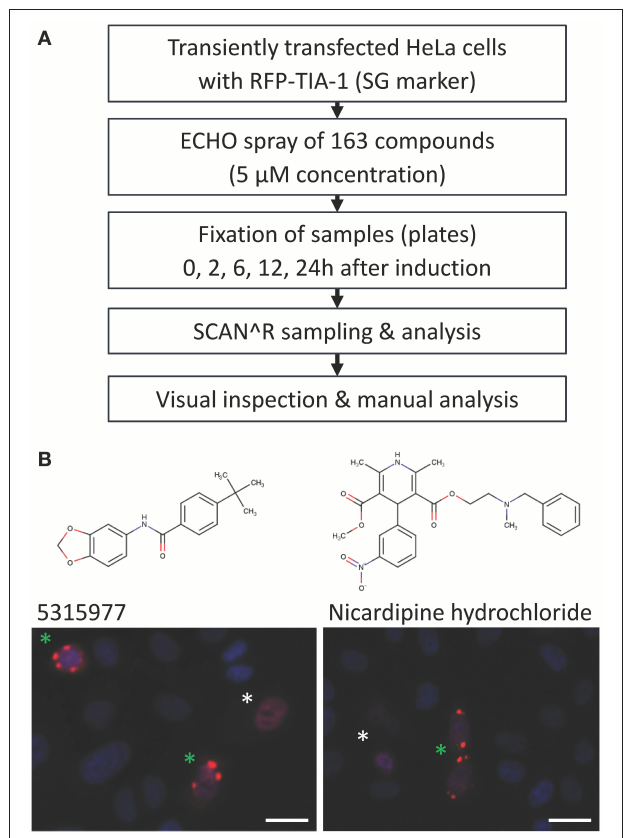
FIGURE 5 | Analysis of induction of stress granules by shortlisted putative miRNA inhibitors in HeLa cells transfected with RFP-TIA-1 reporters. (A) Analysis workflow. (B) Two compounds that induced > 30% stress granule formation in RFP-TIA-positive cells at 5 µ M concentration after 6h. Transfected cells show nuclear localization of TIA-1 (white asterisk), which should change upon induction of stress as TIA-1 relocalizes into stress granules (green asterisk). Scale bars 25 µ